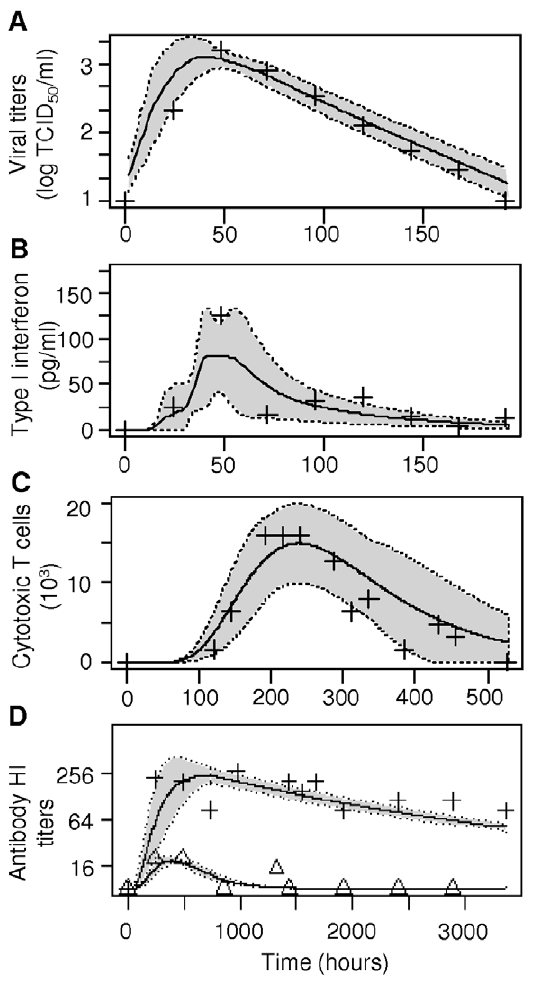
Figure 2. Within-host model dynamics. Output of within-host models is represented by curves. Black line: mean values across models; grey shaded area: standard deviation. Data points from empirical studies are represented by symbols. A. Viral shedding; B. Type I interferon; C. Cytotoxic T cells; D. Immunoglobulins of type A (IgA; triangles) and IgG (crosses). HI: hemagglutination inhibition.